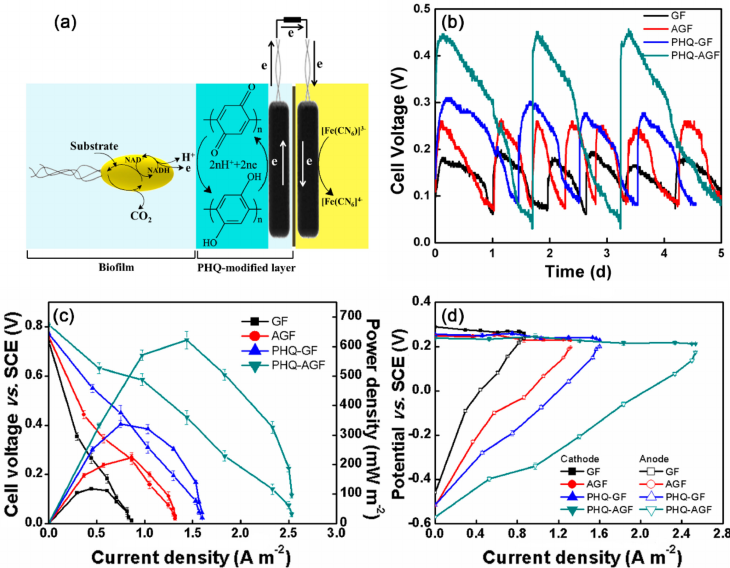
Figure 4. ( a ) Electron transfer pathway mediated by the PHQ-modified anode in a MFC. ( b ) Reproducible cell voltages of MFCs at a 500 Ω external resistor. ( c ) Cell polarization and power density curves of MFCs equipped with different anodes. ( d ) Cathode and anode polarization curves of MFCs equipped with different